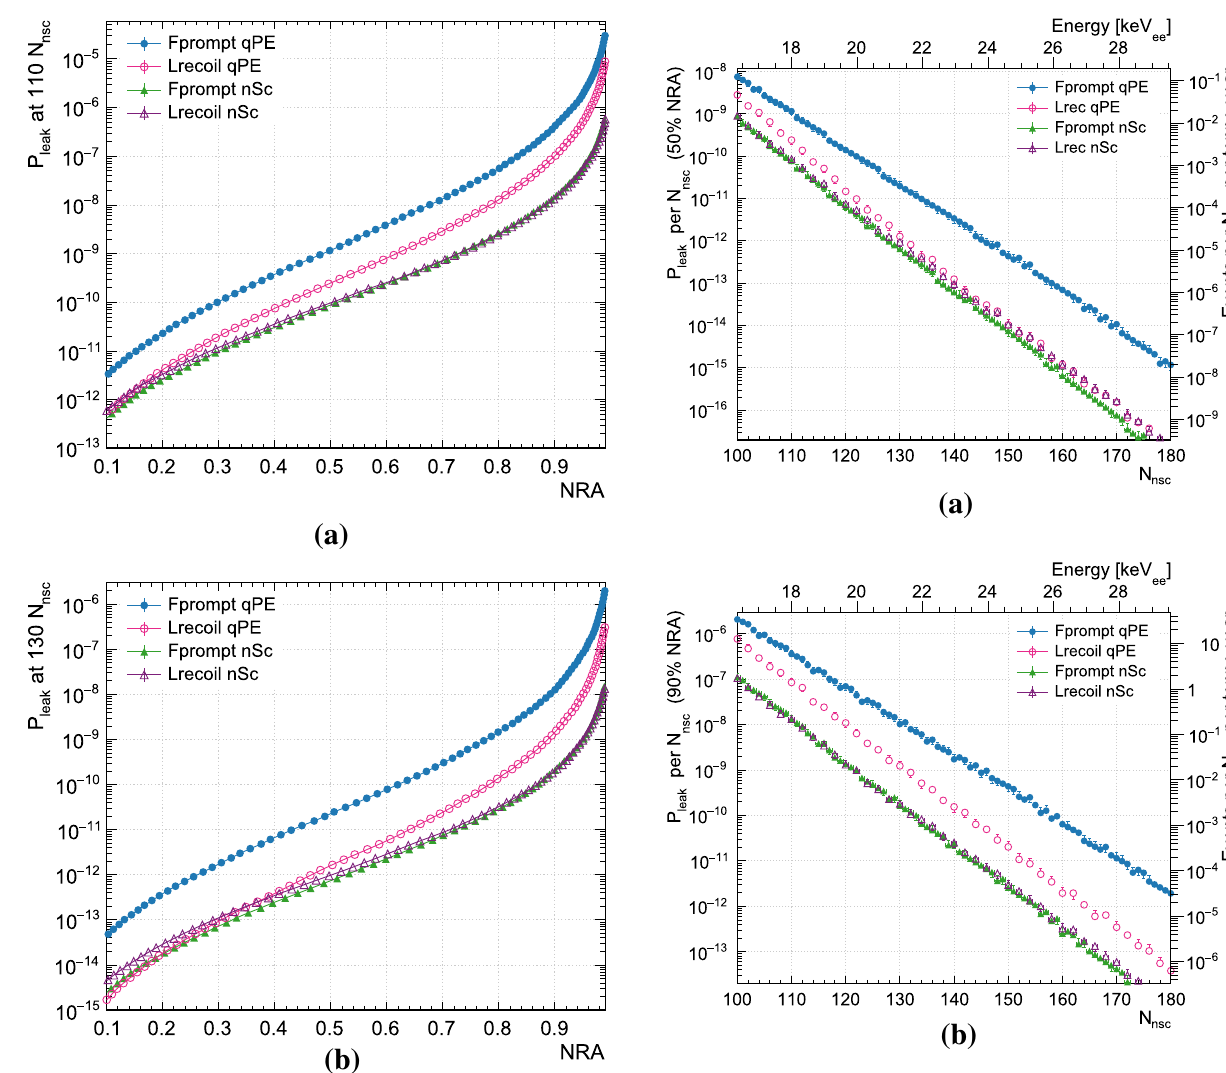
Fig. 6 The leakage probability as a function of N nsc at a 50% and b 90% NRA. Statistical error bars, where not visible, are smaller than the marker